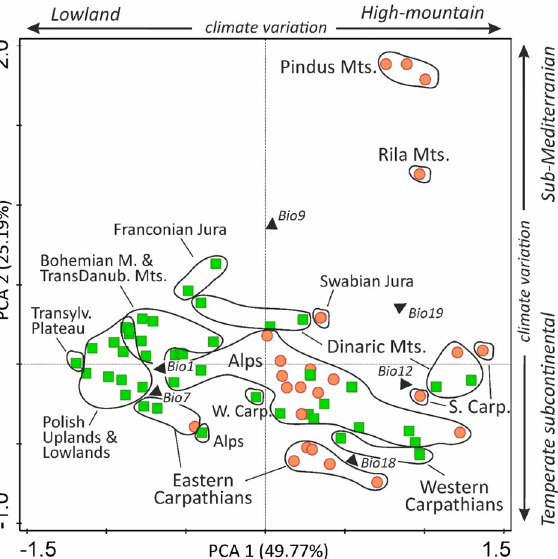
Figure 4. Assignment of the localities of F. amethystina to geographical regions concerning PCA climatic space. Red circles— F. amethystina (2x), green squares— F. amethystina (4x); Black arrowheads indicate the centroids and directions of the climatic factors: Bio1—Annual Mean Temperature, Bio7—Annual Temperature Range, Bio9—Mean Temperature of the Driest Quarter, Bio12—Annual Precipitation, Bio18—Precipitation of the Warmest Quarter, and Bio19—Precipitation of the Coldest